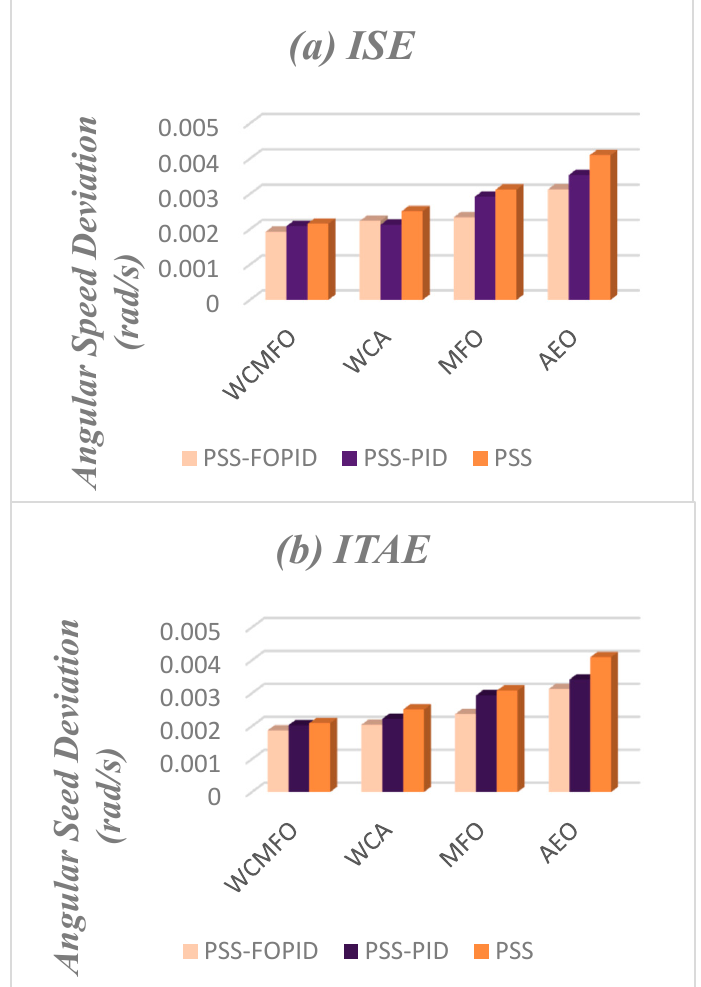
Figure 8. Angular speed deviation values ( a , b ).